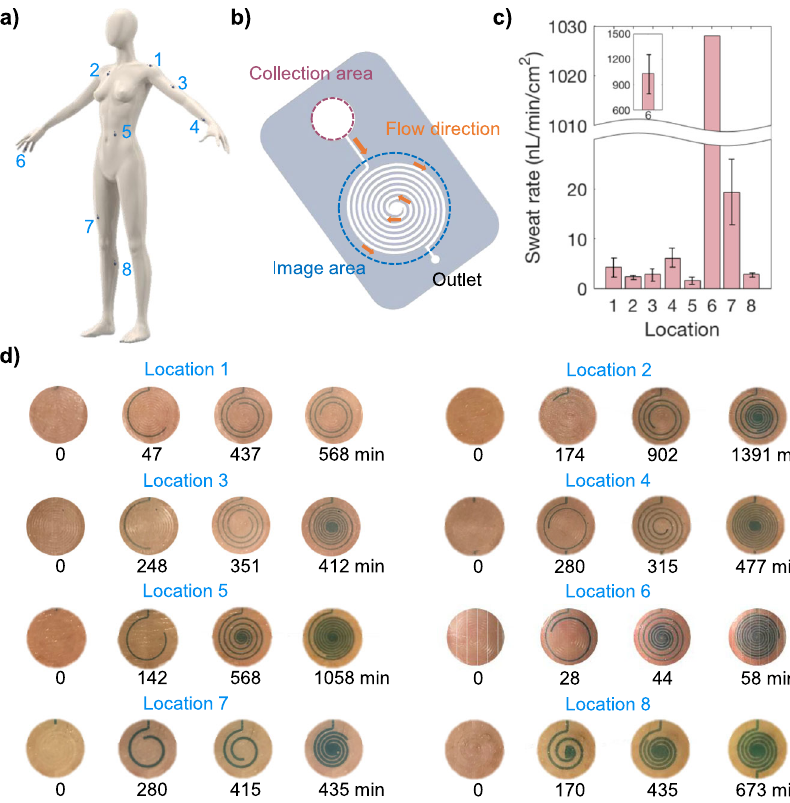
Fig. 2 Collection of at-rest thermoregulatory sweat on various parts of the body. a Sweat patches were placed on 8 different locations including shoulder, chest, bicep, wrist, abdomen, fi nger, thigh, and calf. b The sweat patch used for collection and imaging is displayed. c The bar graph shows a subject ’ s local average sweat rates of regions indicated in ( a ) based on optical tracking of sweat in the microchannel from images like those in ( d ). d Optical images of micro fl uidic sweat collection at different locations and times are displayed. Note that collection areas and micro fl uidic dimensions are different for each location. Two different dimensions discussed in the Results section were utilized, and a collection well with diameter varied from 3 to 10 mm were used. Measured rates were normalized by the collection